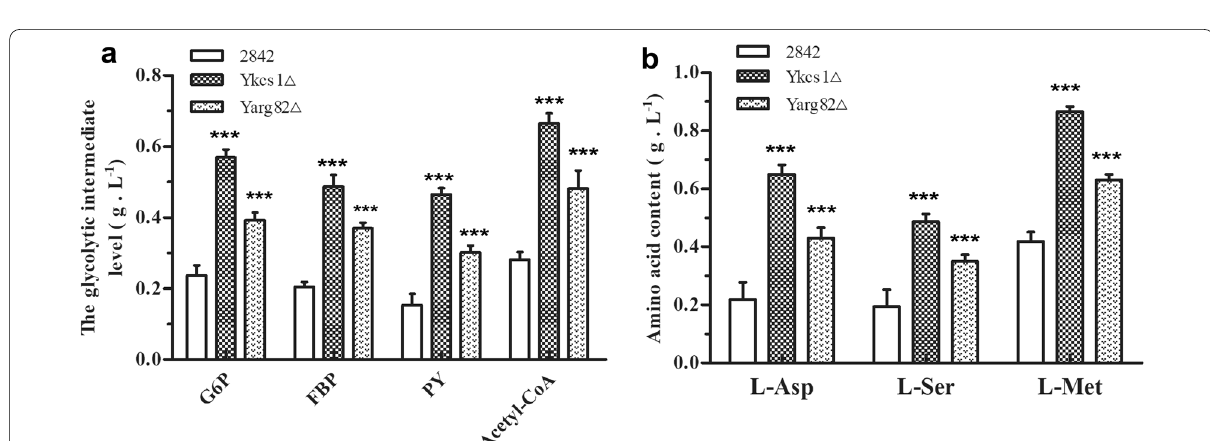
Fig. 5 The deletion of kcs1 and arg82 elevated the intracellular levels of glycolytic intermediates and precursors amino acid for the biosynthesis of SAM in yeast. a The intracellular levels of glycolytic intermediates; b The intracellular levels of the precursors amino acid. Error bars correspond to standard error of mean (SEM) of the biological replicates (n 3). *** denotes significant differences between the recombinant strain and the wild = strain, with p <